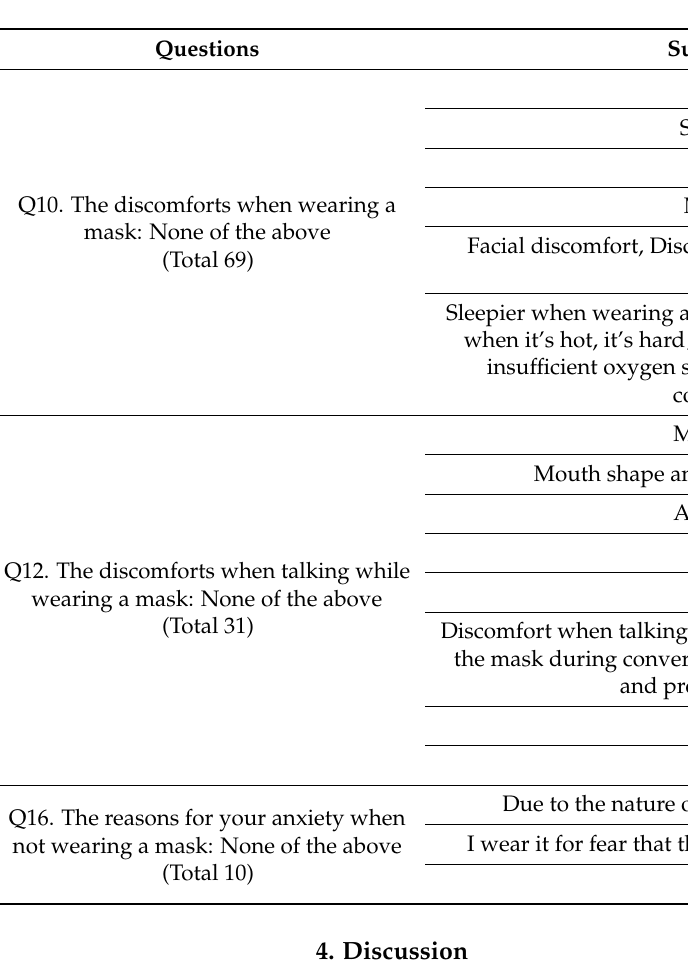
Table 9. Other discomforts and anxiety (subjective